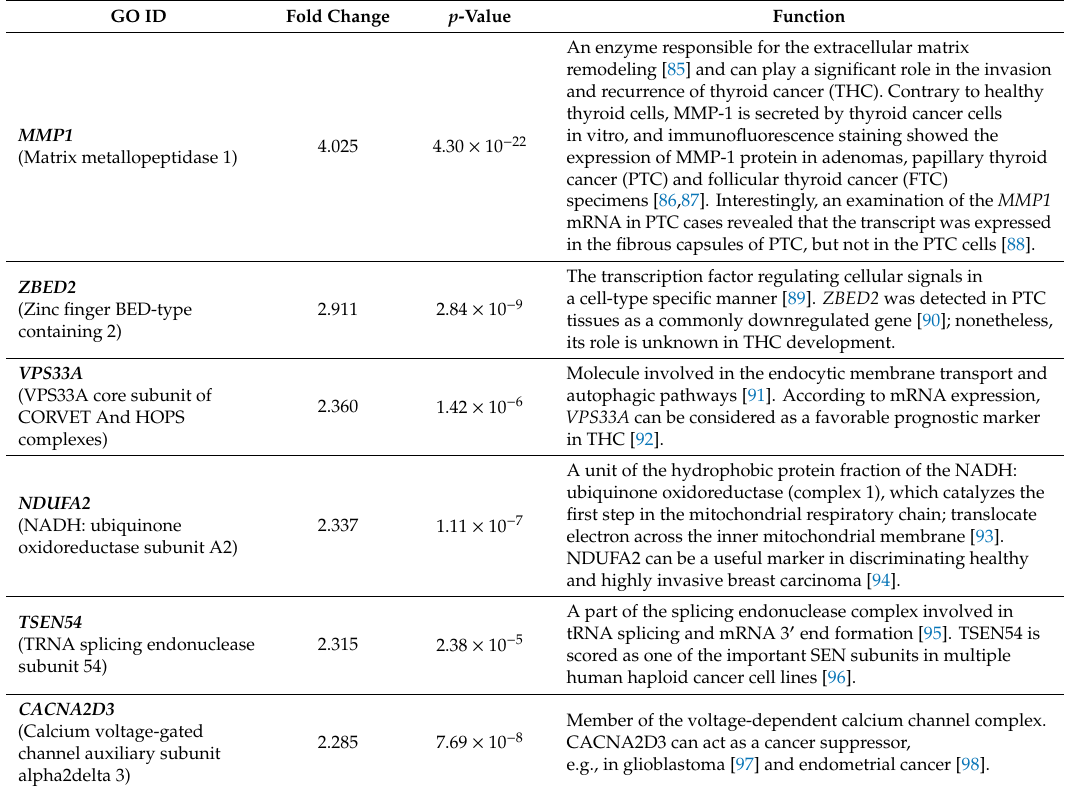
Table 3. List of 20 genes up- and downregulated in CGTH-W-1 cells upon PROX1-knockdown. GO ID Fold Change p